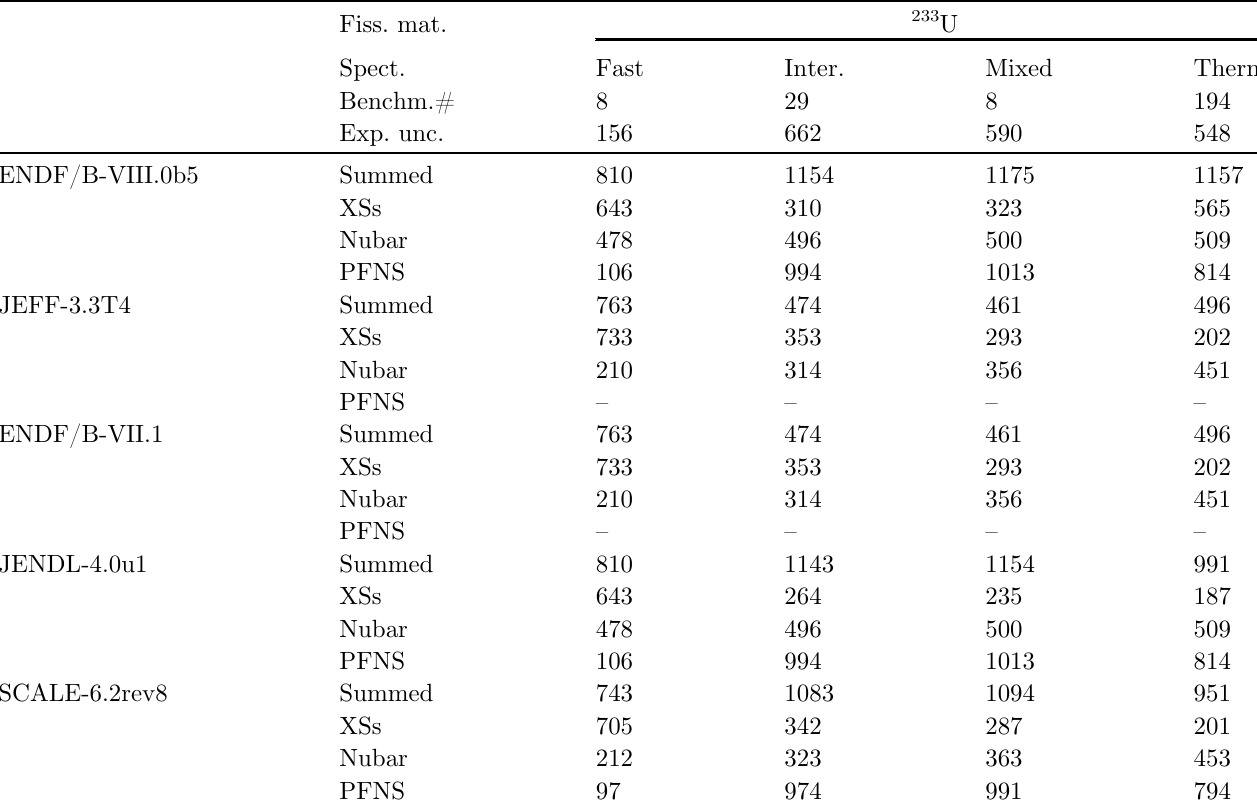
Table 4. Impact of different 233 U nuclear data covariances in ICSBEP suite averaged for fi ssile material and spectrum. Fiss. mat. 233 U Spect. Inter.